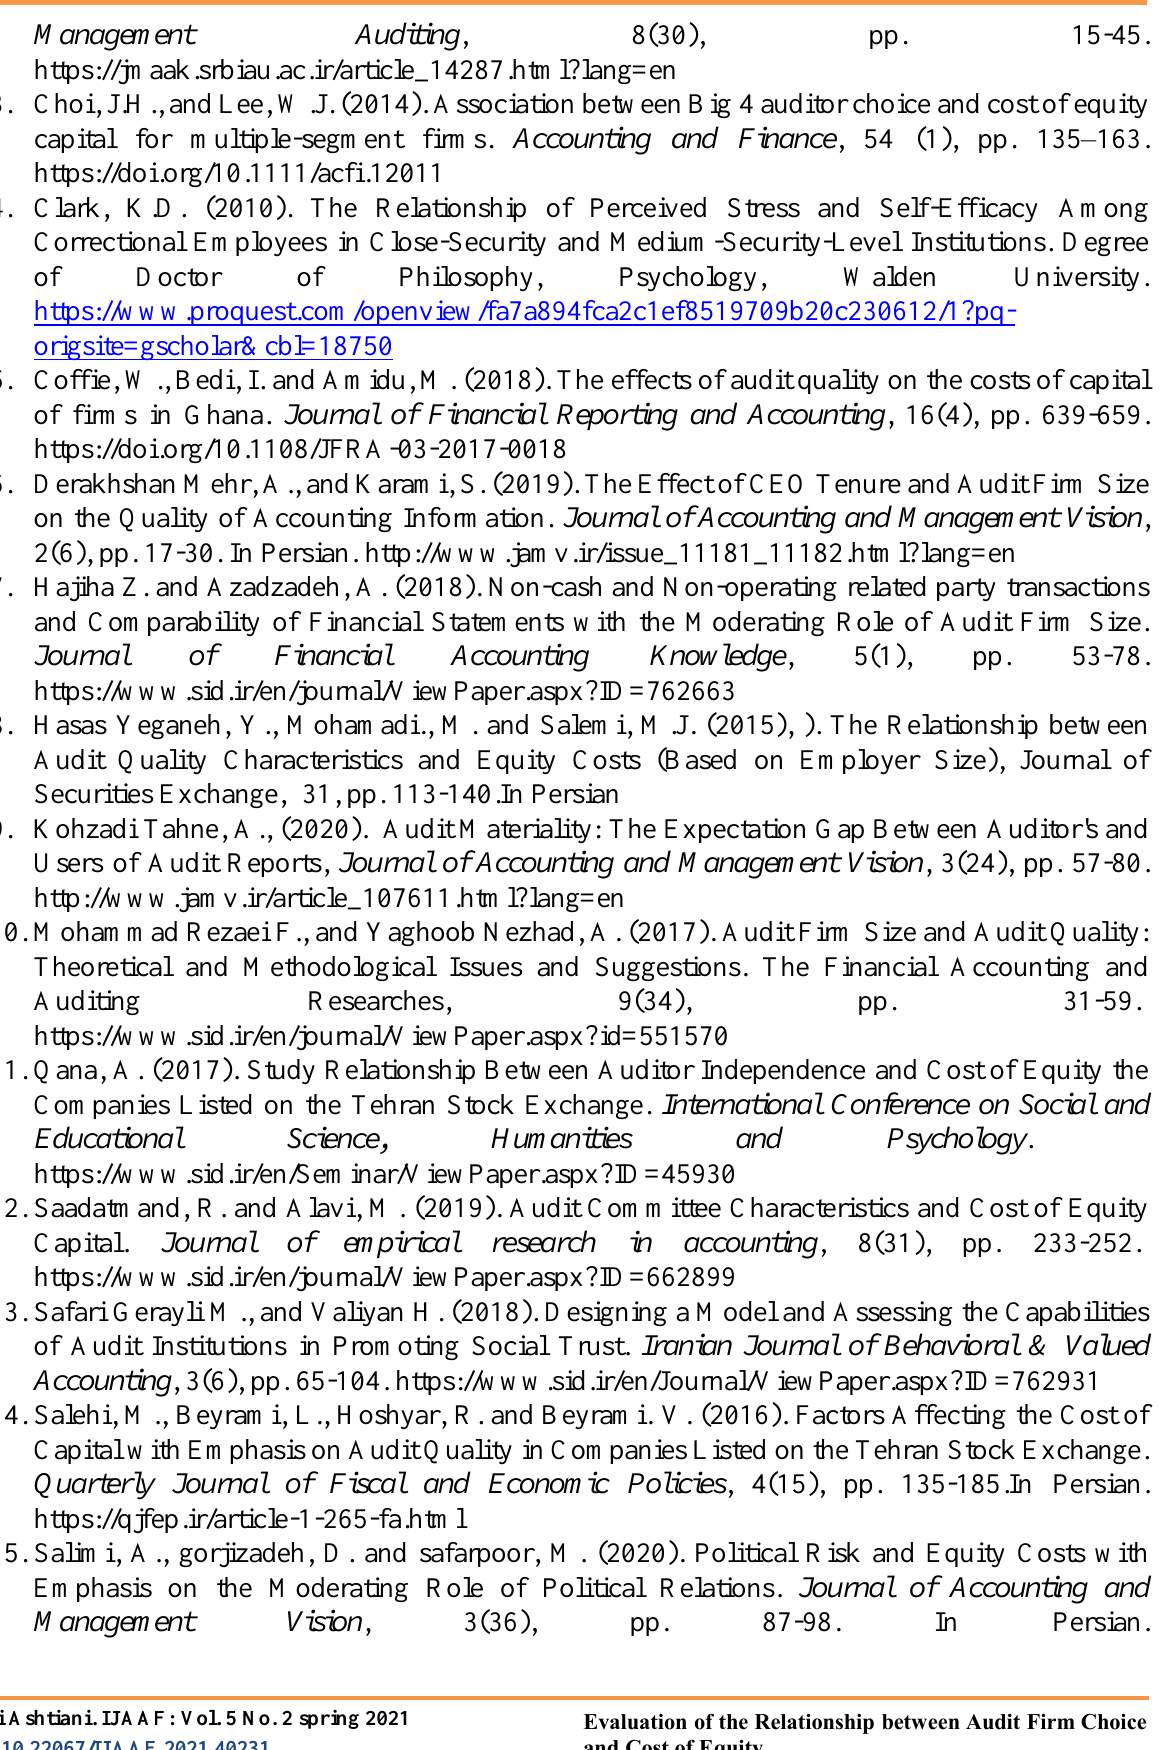
Evaluation of the Relationship between Audit Firm Choice and Cost of